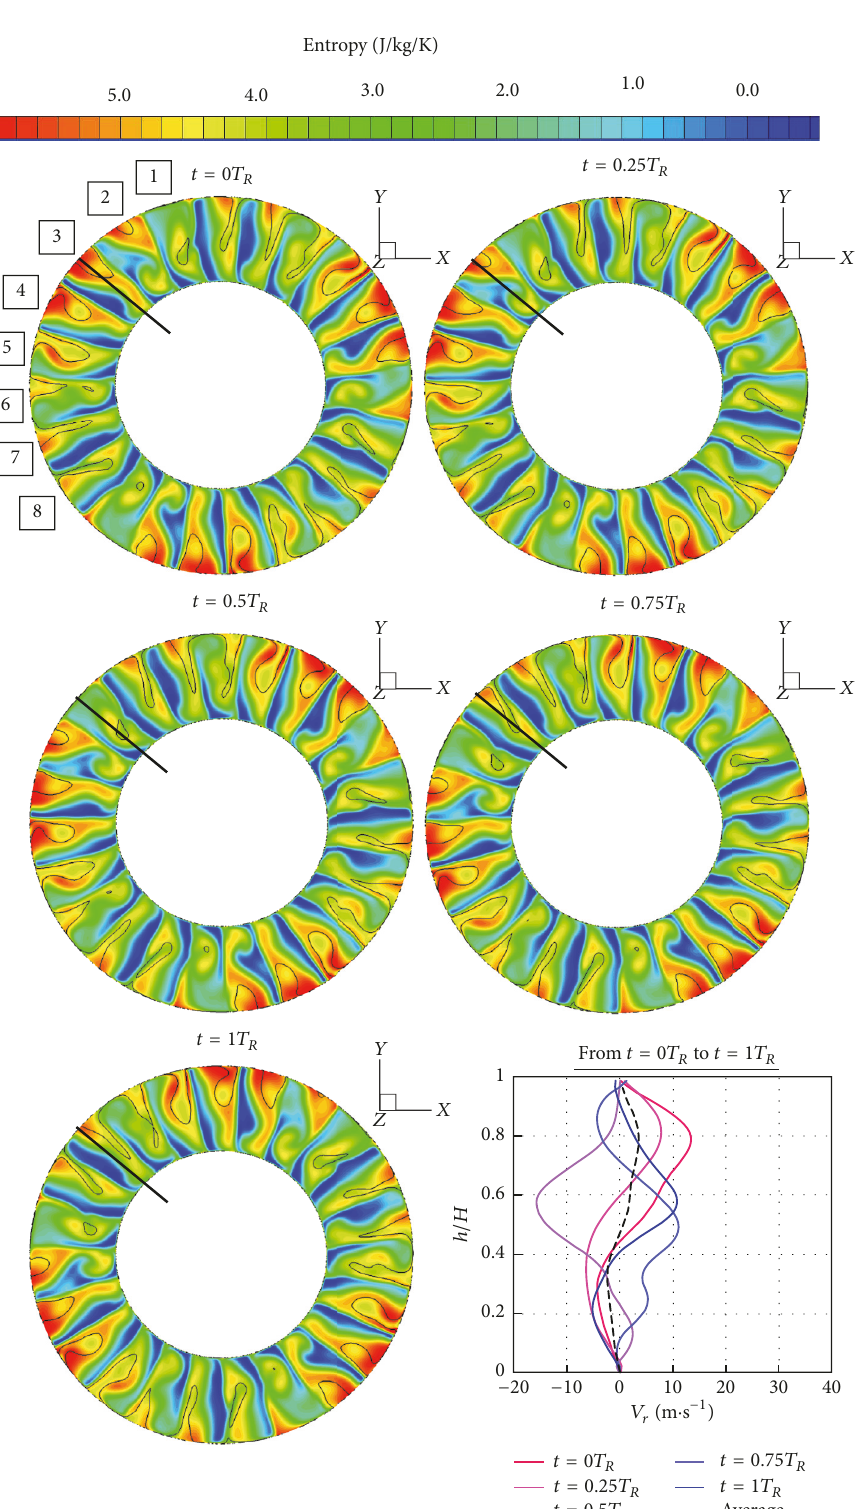
Figure 14: Numerical entropy contours and zero axial velocity isoline at stator outlet. Radial velocity distributions at a given time step (mean profile in